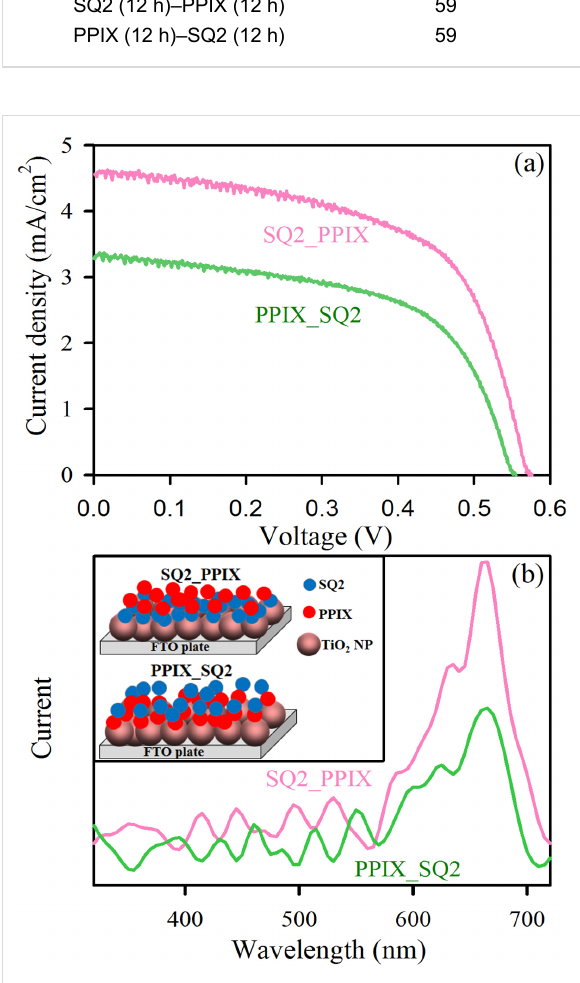
Figure 6: (a) I – V characteristics and (b) wavelength-dependent photocurrent response of the DSSCs with one-by-one dye sensitiza- tion. The inset shows the scheme of the sensitized